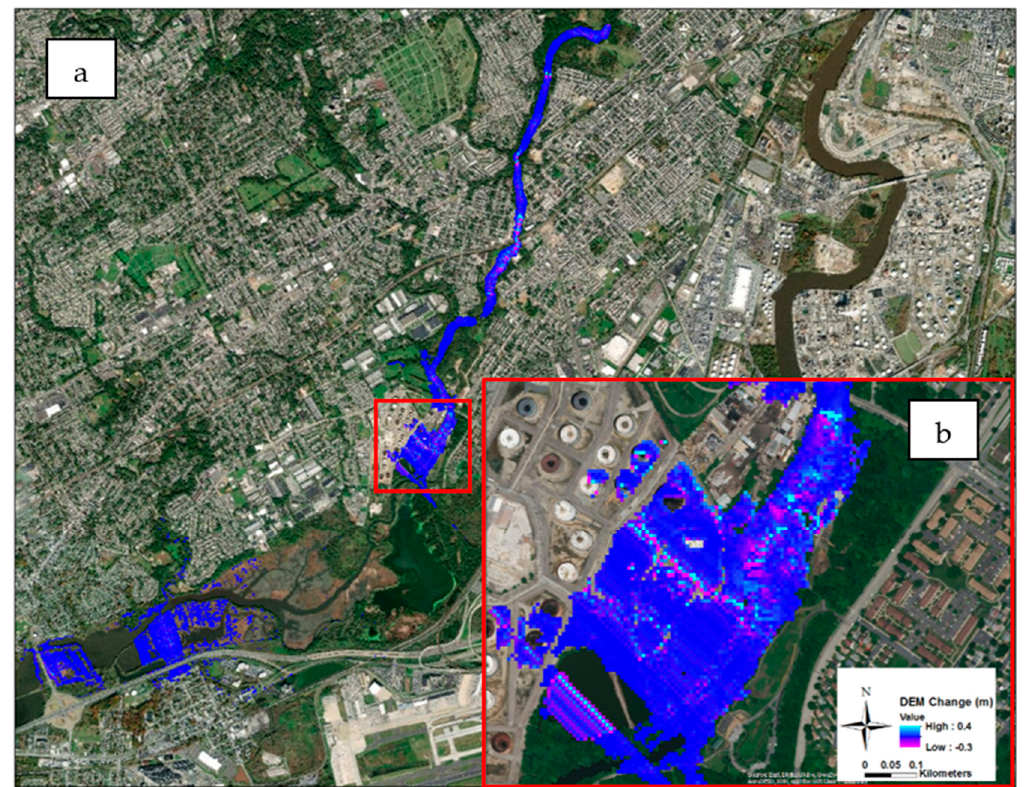
Figure 9. Integrated DEM change from July to September 2011. This depicts the rate of elevation change in the bed and the banks due to floods in that time window ( a ). Positive and negative values in DEM change indicate deposition and erosion respectively. Image ( b ), a close-up window of the transitional zone, shows the deposition (red) and erosion (yellow) at the entrance of the BW zone. As expected, the model output showed that higher discharges caused more geomorphic